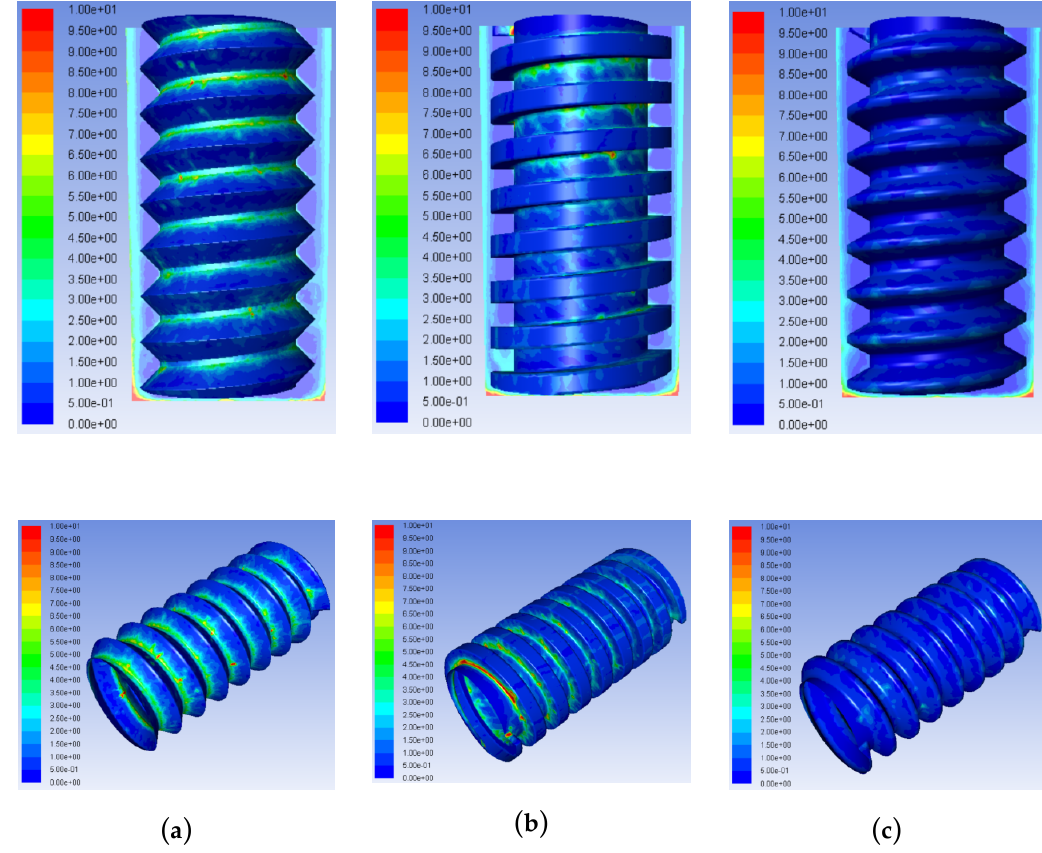
Figure 4. Concentration contours of processed products in the machining gap using tool tube electrodes with different helical shapes: ( a ) Triangle; ( b ) rectangle; and ( c ) trapezoid.